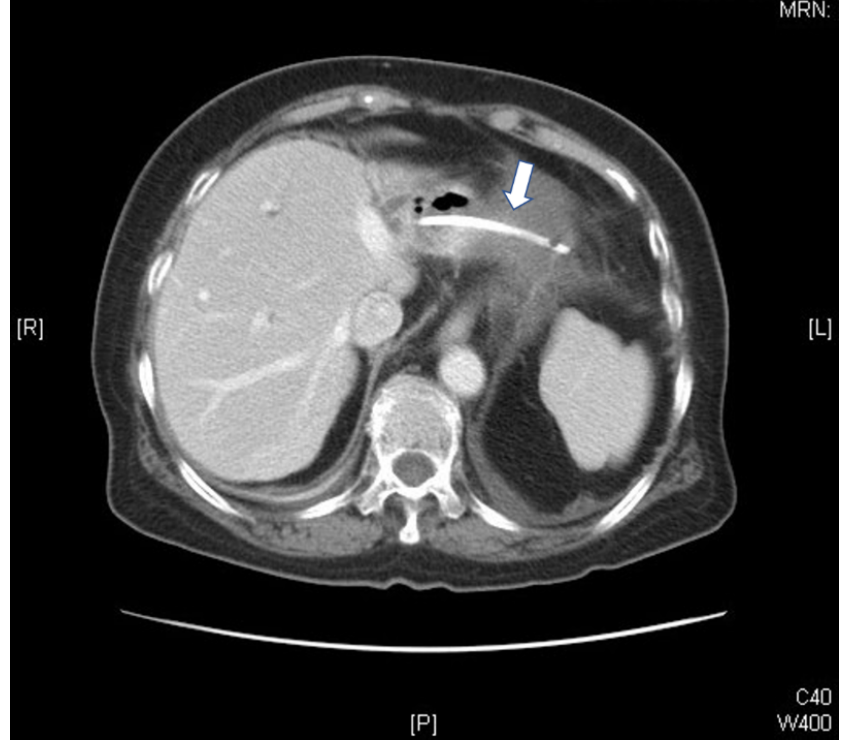
Figure 1. Migrated biliary stent in the abdomen.